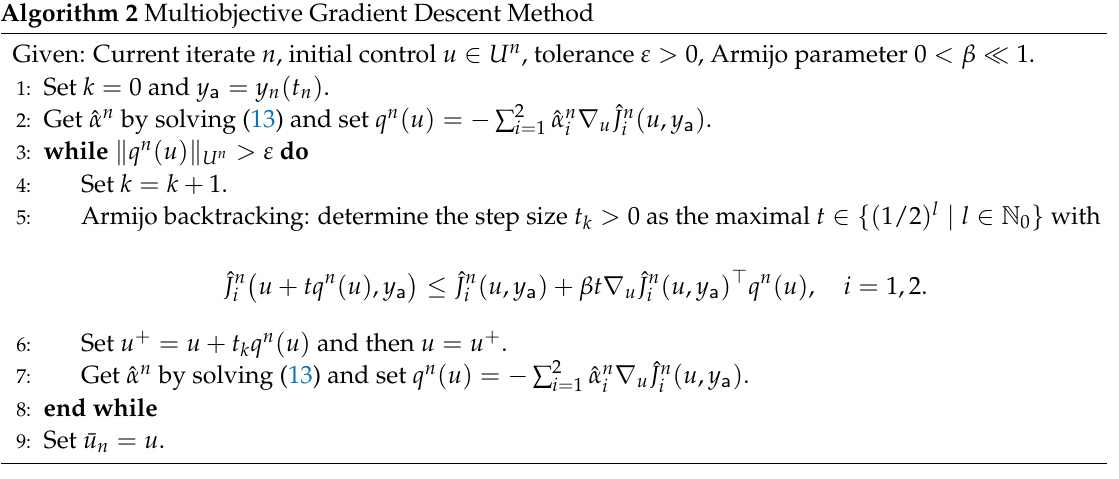
Algorithm 2 Multiobjective Gradient Descent